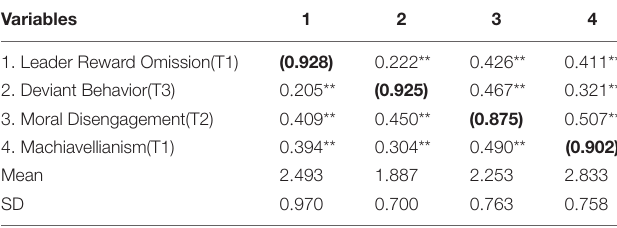
TABLE 1 | Descriptive statistics and correlations of variables.